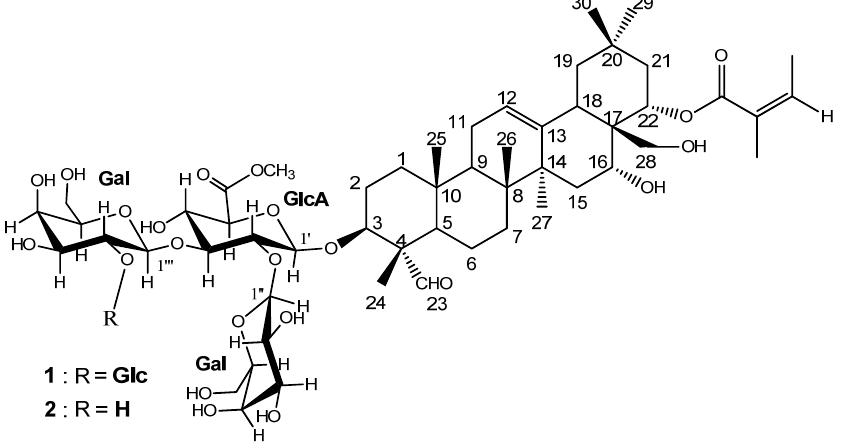
Figure 1. Structures of oleiferasaponins C 4 and C 5 ( 1 , 2 ).